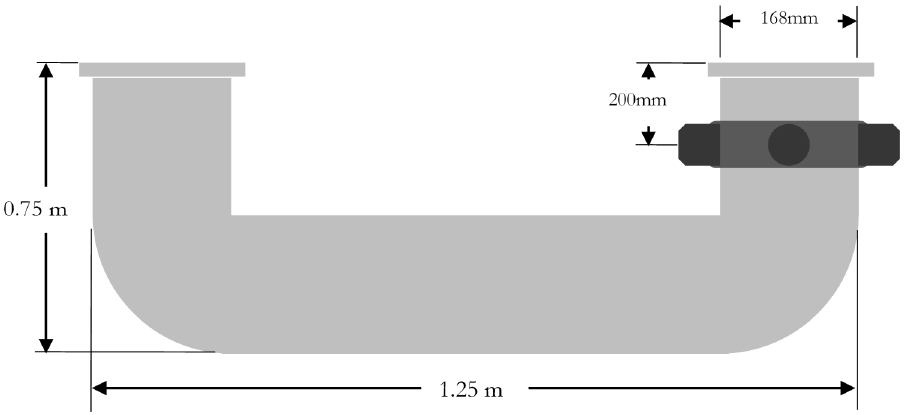
Figure 17. Schematic of U-shaped pipe specimen.